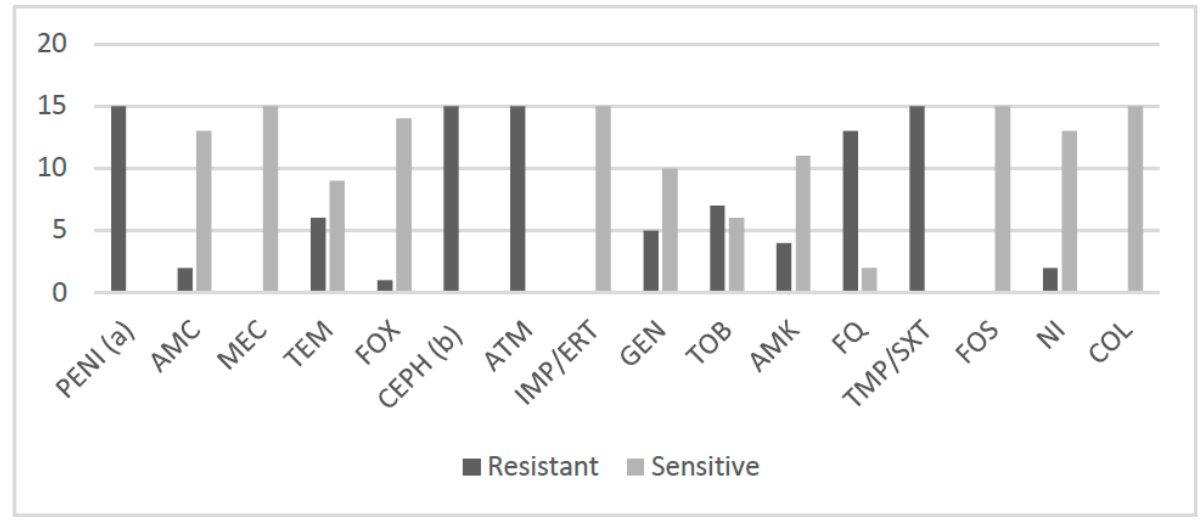
Figure 2. Proportion of antibiotic resistances among the 15 ESBL-E. PENI (a), ampicillin, ticarcillin, piperacillin; AMC, amoxicillin-clavulanic acid; MEC, mecillinam; TEM, temocillin (susceptible with increased exposure); FOX, cefoxitin; CEPH (b), cefixime, cefuroxime, ceftriaxone, ceftazidime, cefepime; ATM, aztreonam; IMP/ERT, imipenem/ertapenem; GEN, gentamicin; TOB, tobramycin; AMK, amikacin; FQ, fluoroquinolones (ciprofloxacin, ofloxacin); TMP/SXT, trimethoprim/sulfamethoxazole-trimethoprim; FOS, fosfomycin; NI, nitrofurantoin; COL, colistin.